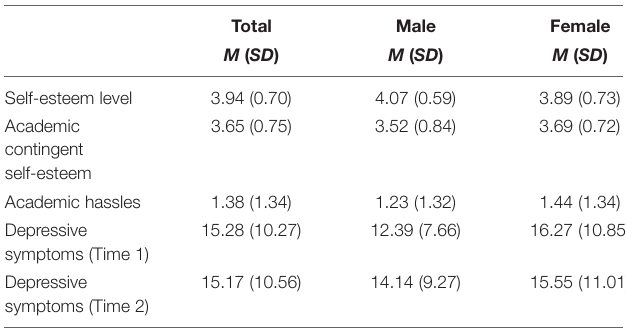
TABLE 3 | Mean scores and standard deviations of self-esteem level, aCSE, academic hassles, and DS for the total group and by